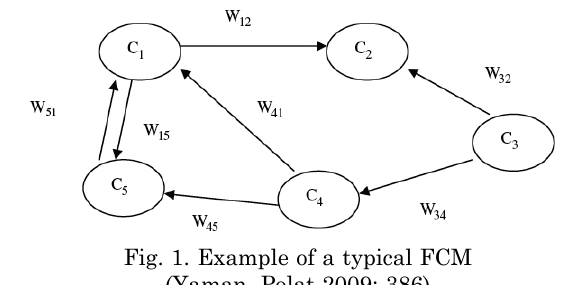
Fig. 1. example of a typical